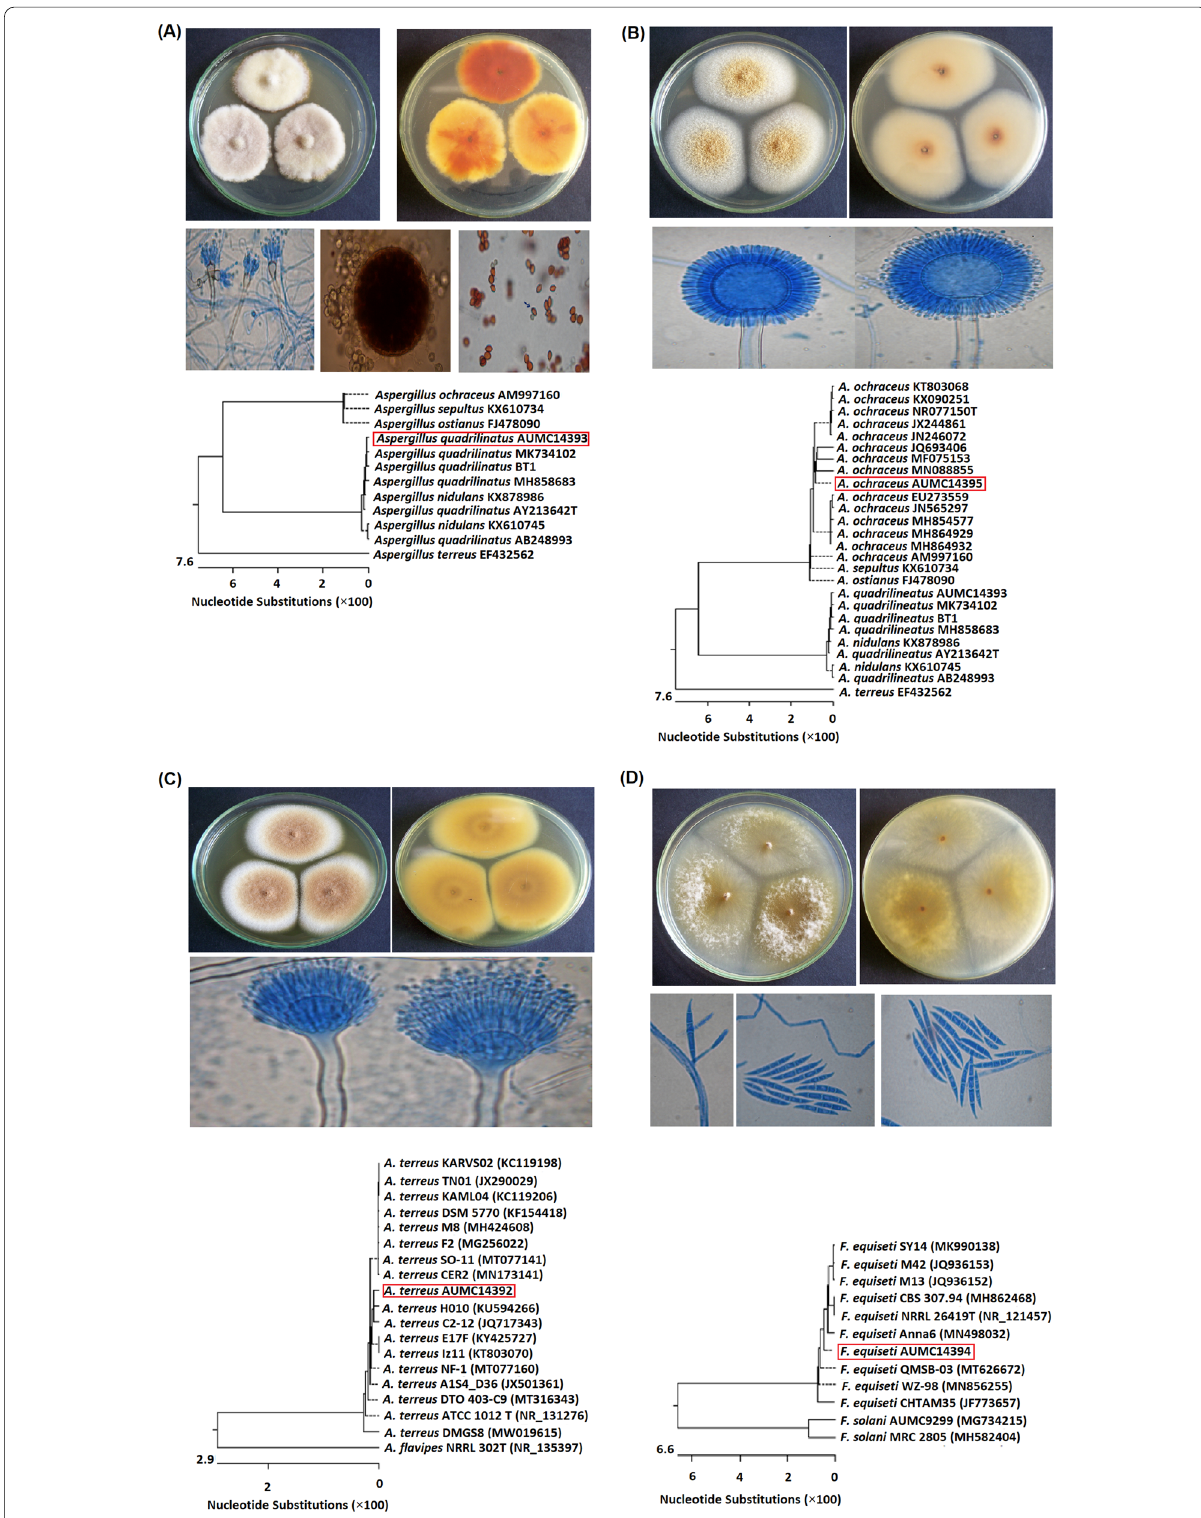
Fig. 1 Morphological and molecular characteristics of the SeNPs producing fungal strains. Colonial growth, microscopic features, and phylogenetic tree of A. quadrilineatus MZ571533 ( A ), A. ochraceus MZ571534 ( B ), A. terreus MZ571560 ( C ), and F. equiseti MZ571561 ( D